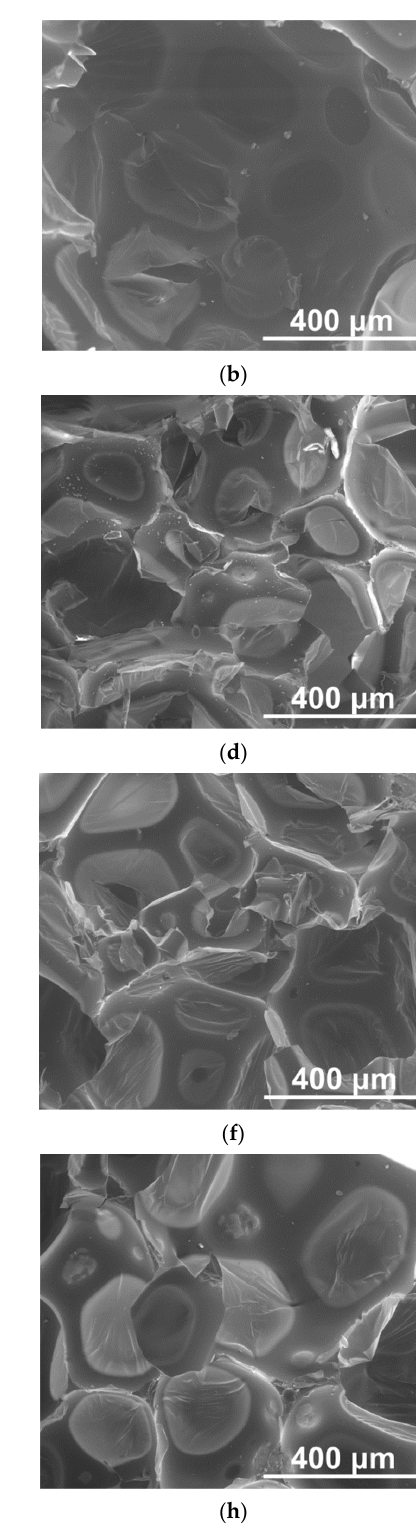
Figure 4. SEM images of the cross-sections of PUR foams modified with 5 ( a , b ), 10 ( c , d ), 15 ( e , f ), and 20 wt.% ( g , h ) of FA (left column) and M (right column). Magnitudes ×